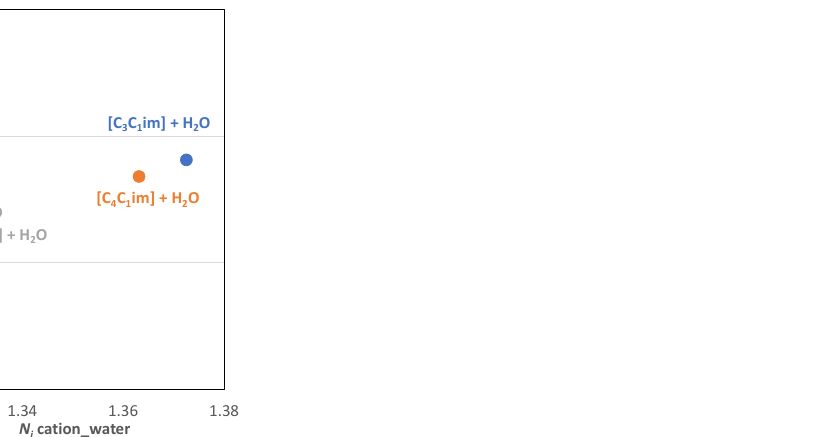
Figure 5. Average number of contact neighbors ( N i ) for pure ILs and aqueous mixtures X IL = 0.70 (wt IL = 98%) of [C 3 C 1 im][NTf 2 ], [C 4 C 1 im][NTf 2 ], and [iC 4 C 1 im][NTf 2 ] as a function of the number of carbons in alkyl chain: ( a ) tail–tail and ( b ) cation–anion aggregates.